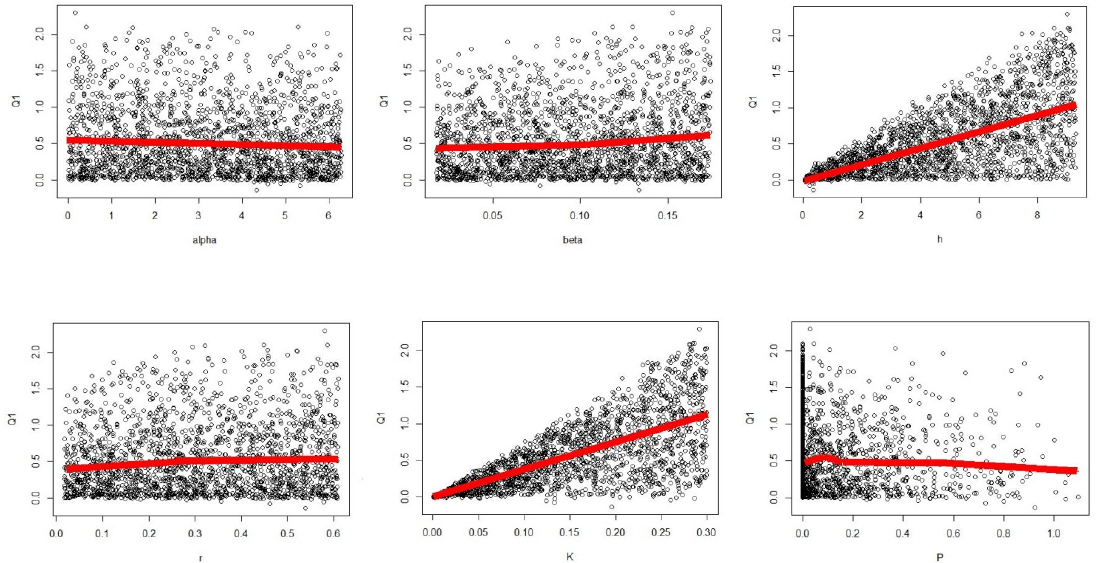
Figure 4. Groundwater infiltration scatter plots for the first random sample (Q1). GWI (Q1) units are m 3 day − 1 m − 1 ; pressure head (P i ), radius (r), groundwater head (h) units are m; defect location ( α ) and size ( β ) units are radians; hydraulic conductivity (K) units are m s − 1 .